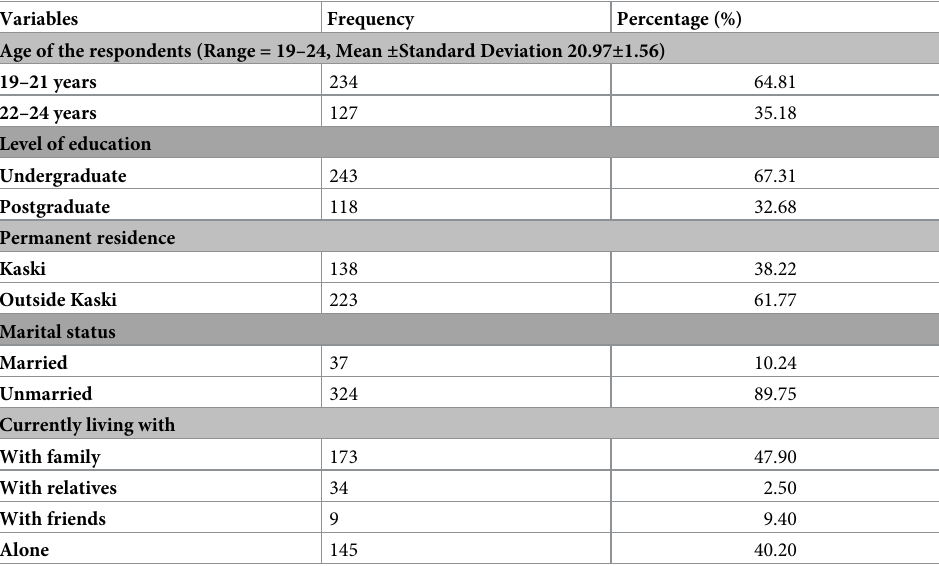
Table 1. Socio-demographic variables (n =